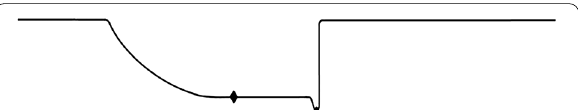
Fig. 2 Schematic illustration of a cross section of the surface field intensity with an anisotropic configuration. The SAA center based on the minimum (Min, denoted by a point) does not represent well the center of the anomaly. The center of mass method (CM0 or CM1) gives an adequate center denoted by a diamond